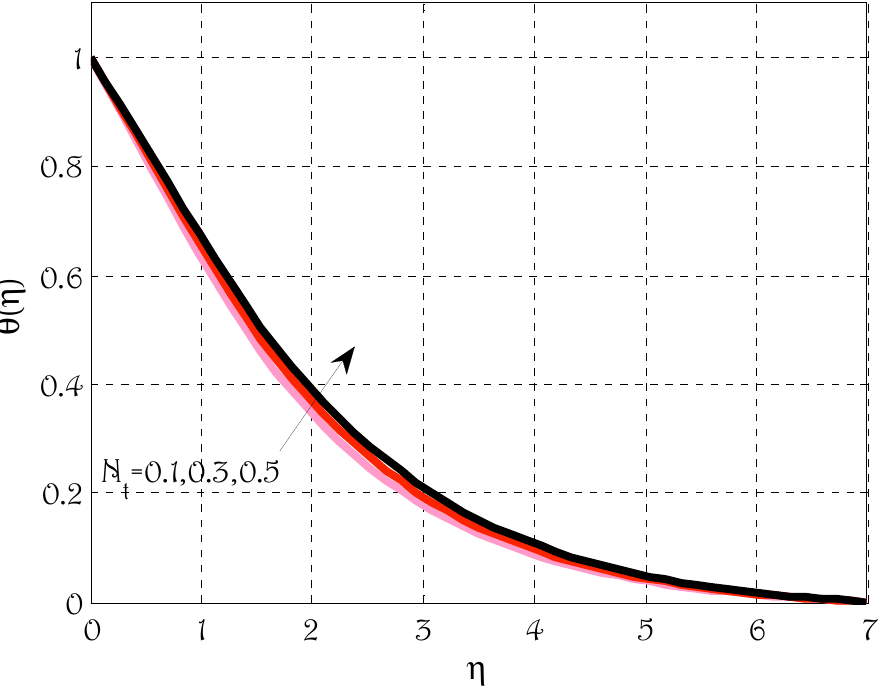
Figure 6. Effect of thermophoretic parameter N t on temperature profile θ using k p = 0.5, M = 0.5, R d = 0.7, λ = 0.1, E c = 0.1, N b = 0.1, P r = 1.9, S c = 1.4, γ = 0.1.